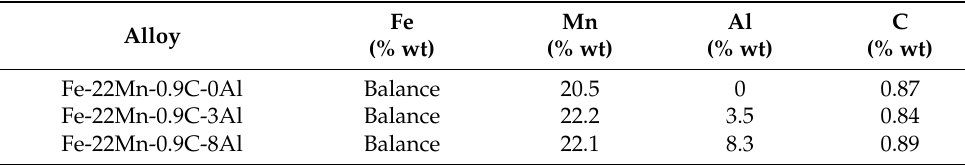
Table 2. Fe-Mn-Al-C alloy chemical